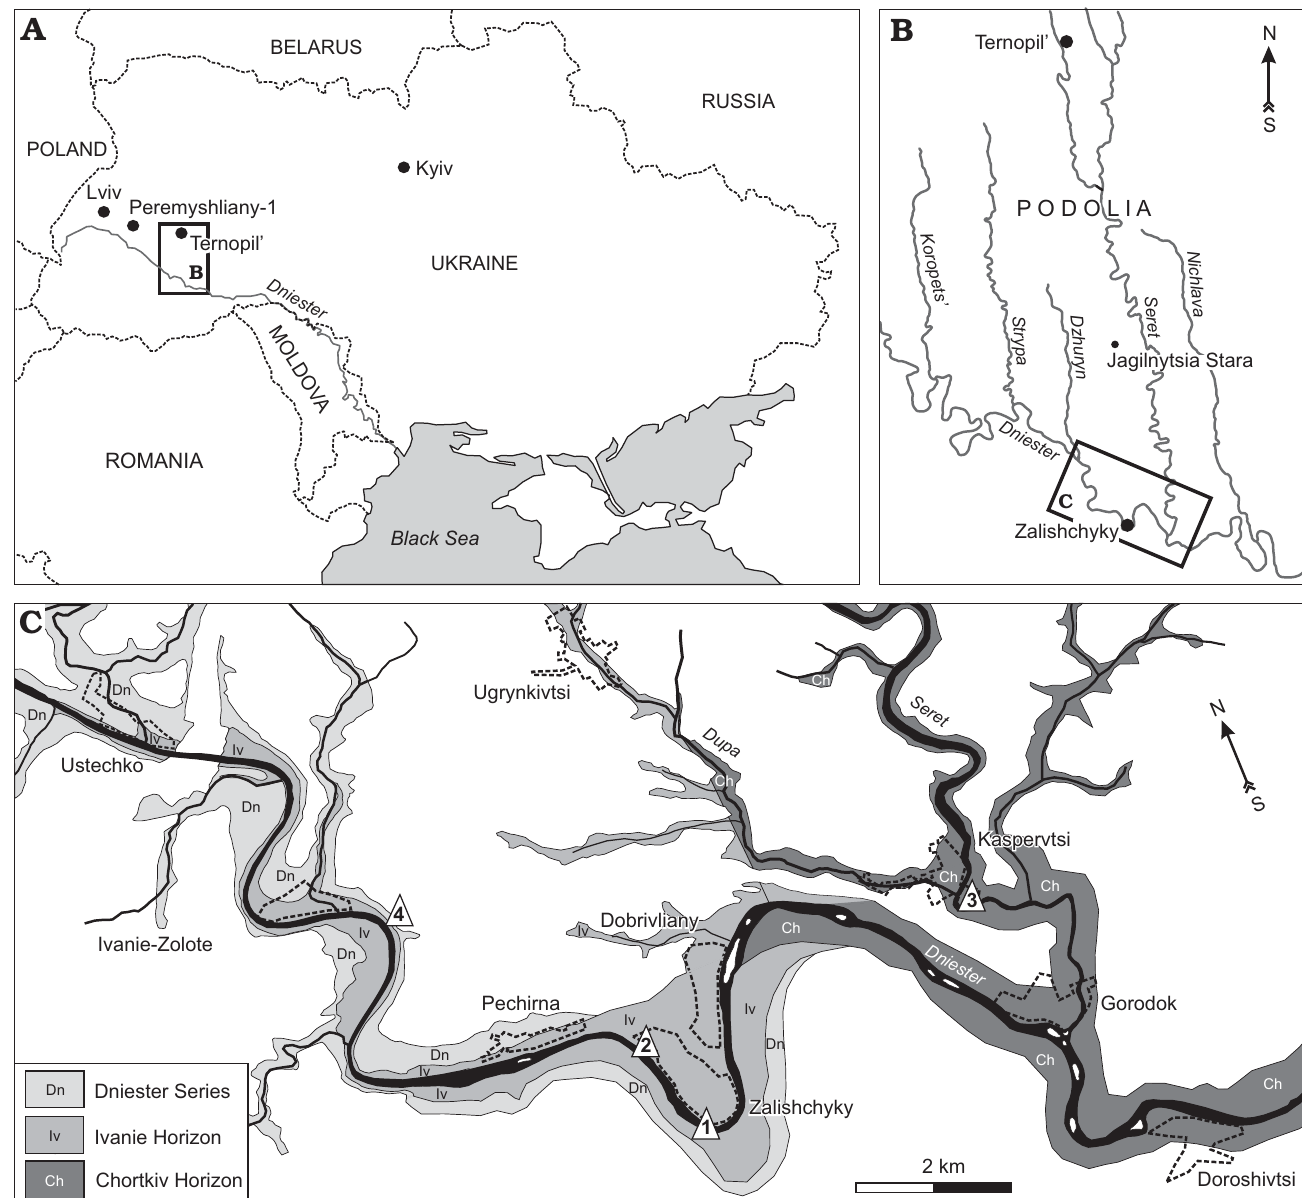
Fig. 1. A . Location of the study area in Ukraine with position of Podolia. B . Map of the studied region. C . Lower Devonian exposures (modified from Voichyshyn and Szaniawski 2012) with points of sampled sections (triangles